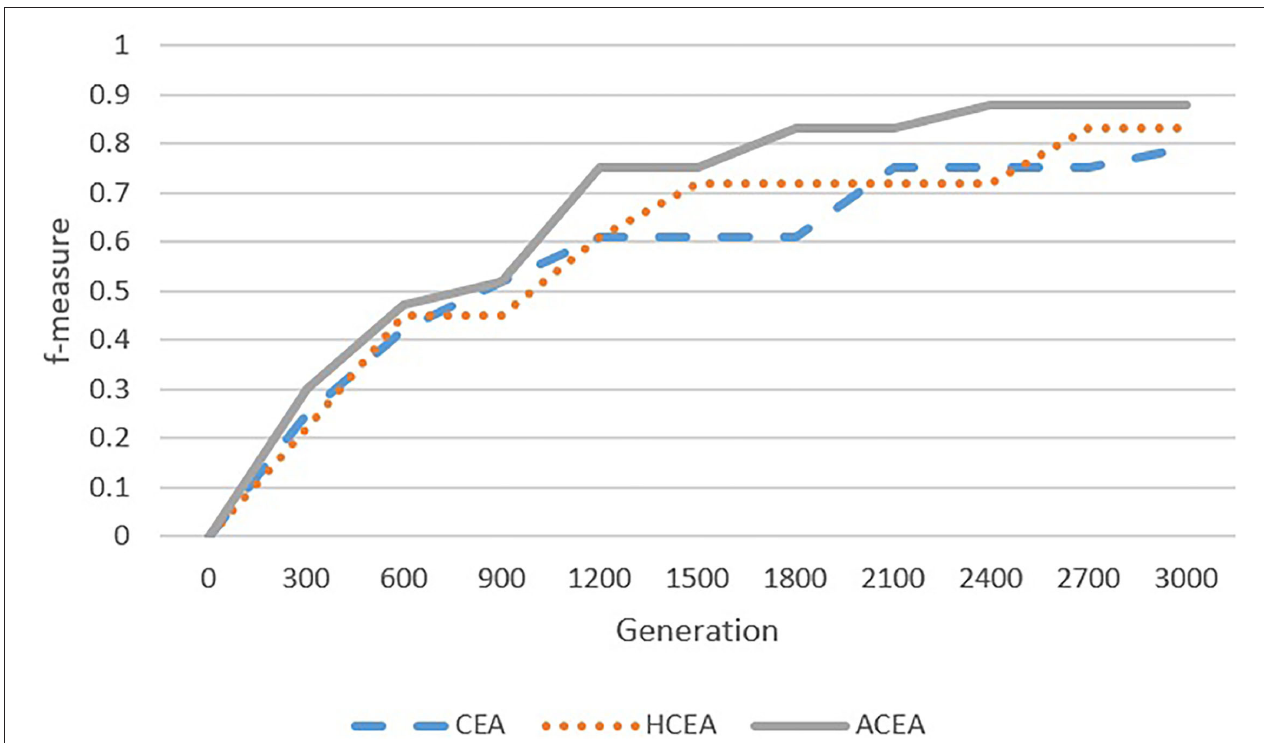
FIGURE 6 | Comparison among ACEA, CEA, and HCEA in terms of convergence graph on ENVO-SWEET.